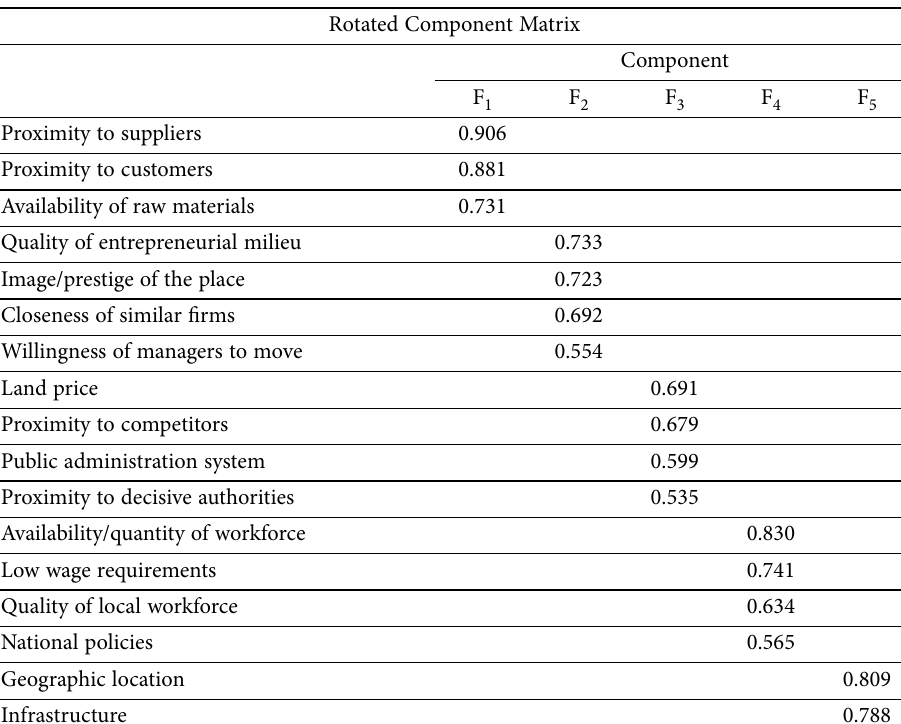
Table 6. Results of factor